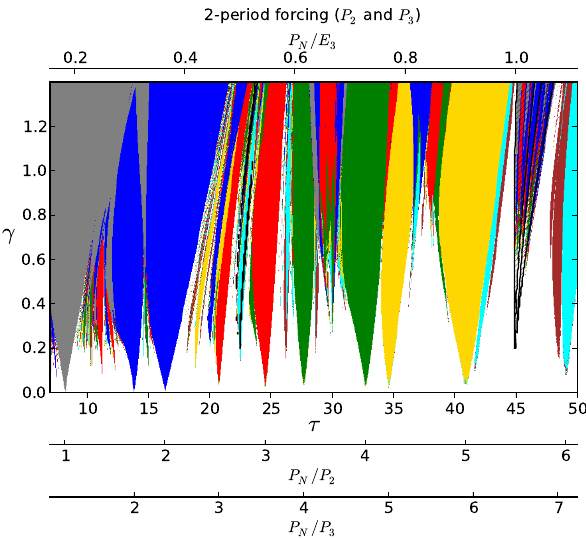
Fig. 11. Number of distinct solutions simulated with the van der Pol oscillator ( β = 0 . 7, α = 30, τ = 41ka and γ = 0 . 6 with 2-period forcing as in Fig. 8, as a function of the time t back at which 121 distinct initial conditions are considered. The actual stable pullback attracting set(s), in the rigorous mathematical sense, is (are) found for t back → −∞ .